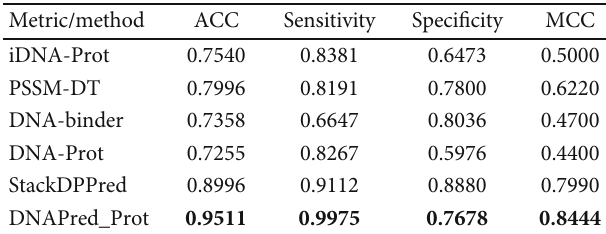
Table 8: Comparison of jackknife results with state-of-the-art